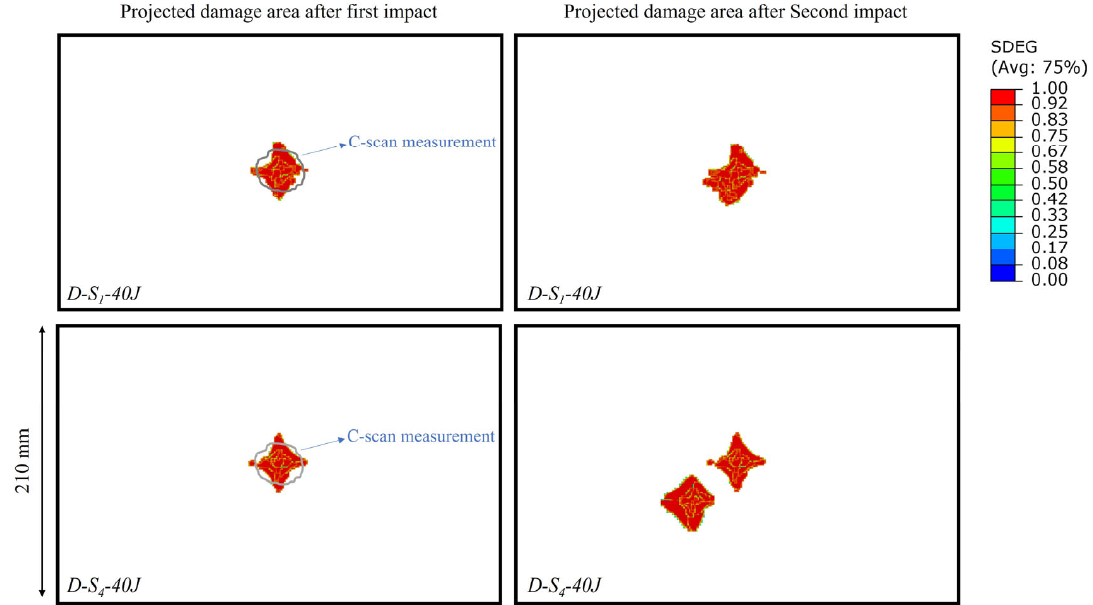
Figure 11. Comparison of the projected damaged area of D ‐ S1 ‐ 40 J and D ‐ S4 ‐ 40 J models after the first (at center) and second (off ‐ center) impacts.